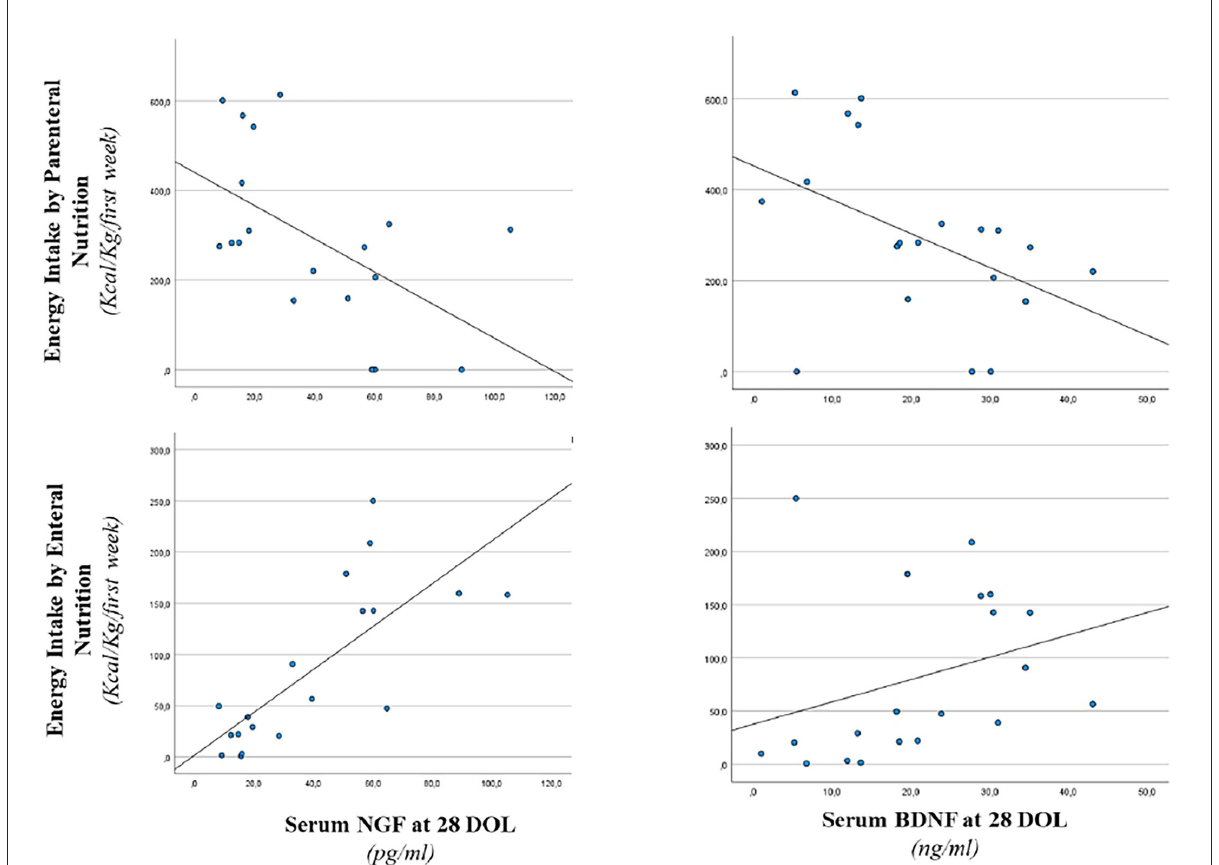
FIGURE2 Correlation between serum NGF and BDNF level at 28 days of life and energy intake. Enteral nutrition: serum NGF ( r = 0.746, p < 0.001) and serum BDNF ( r = 0.493, p < 0.05). Parenteral nutrition: serum NGF ( r = − 0.466, p < 0.05) and serum BDNF ( r = − 0.530, p <